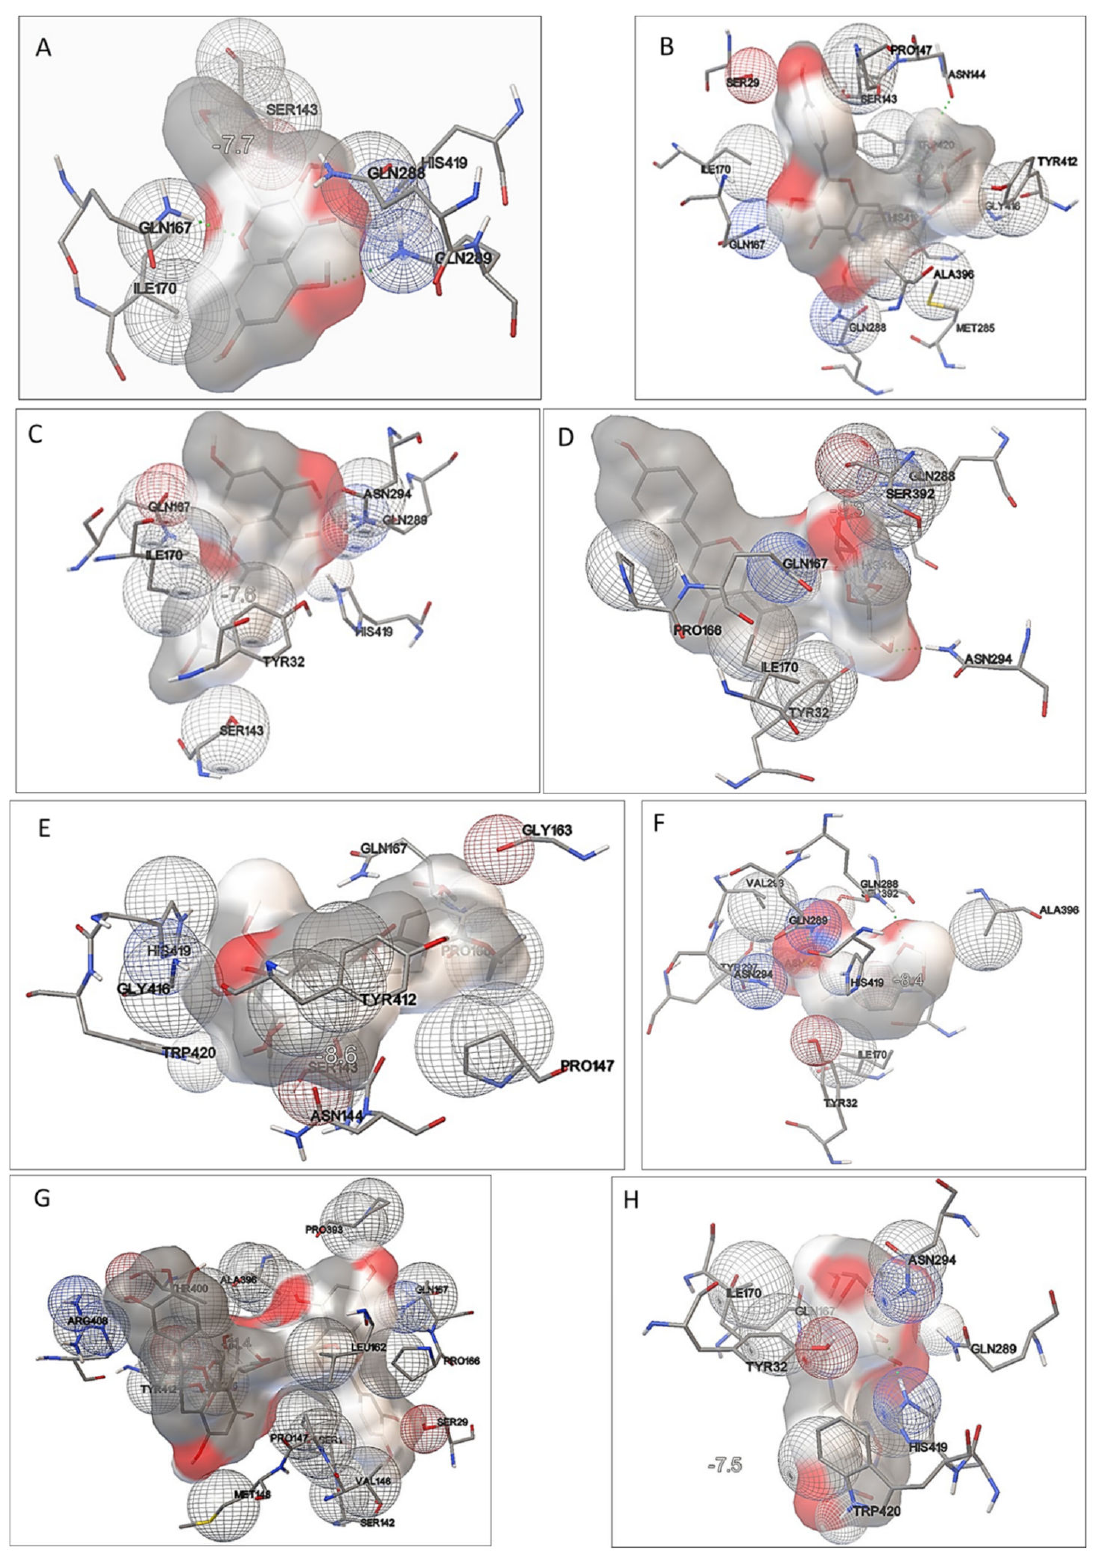
Figure 10. Graphical representation of the binding site of the lowest energy GLUT5-ligand complexes: GLUT5- kaempferol ( A ); GLUT5-kaempferol-3- O -glycoside ( B ); GLUT5-apigenin ( C ); GLUT5-apigenin-7- O -glucoside ( D ); GLUT5- epigallocatechin-3-gallate (ECGC) ( E ); GLUT5-MSNBA ( F ); GLUT5-procyanidin C1 ( G ); GLUT5-NBDF ( H